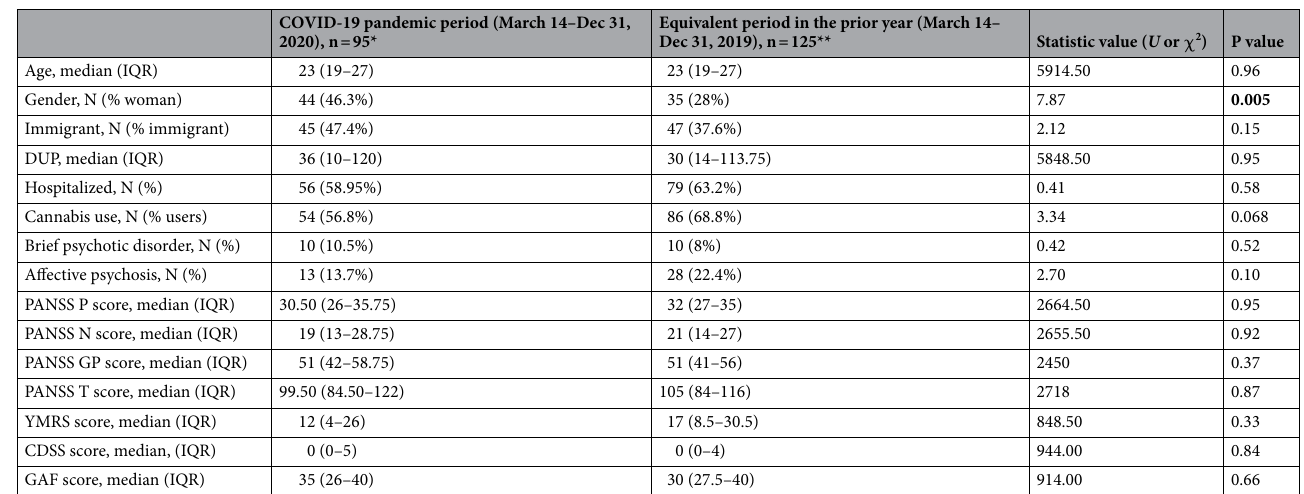
Table 2. Sociodemographic and clinical variables of the two groups of FEP patients. Significant values are in [bold]. N sample size, IQR interquartile range, DUP duration untreated psychosis, n sample size, PANSS P Positive and Negative Syndrome Scale positive, PANSS N Positive and Negative Syndrome Scale negative, PANSS GP Positive and Negative Syndrome Scale general pathology, PANSS T Positive and Negative Syndrome assessed in 46 patients. **PANSS scores were assessed in 80 patients; YMRS, CDSS and GAF scores were assessed in 42